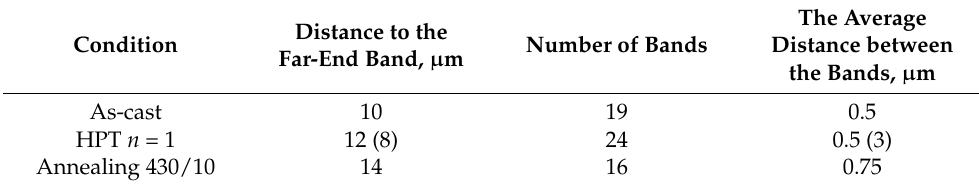
Table 2. Pattern parameters of band formation at bonded-interface indentation tests on BMG Vit105 samples in various states—Distances from the indenter tip imprint to the farthest band, number of observed bands, average distance between bands, [ µ m]. Where indicated, without parentheses refers to all bands, in parentheses—only to intense shear bands.